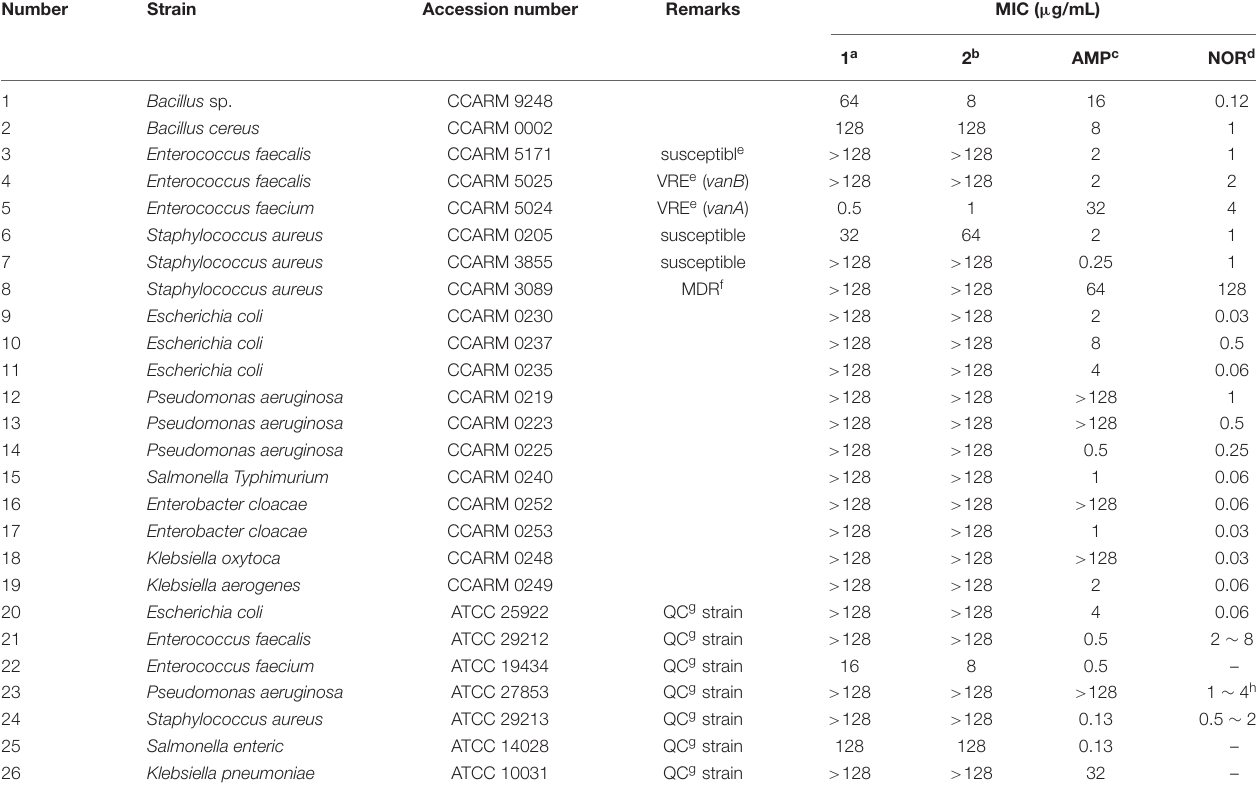
TABLE 2A | Antibacterial activity of lenzimycins A and B ( 1 - 2 ) against a panel of bacterial species. Number